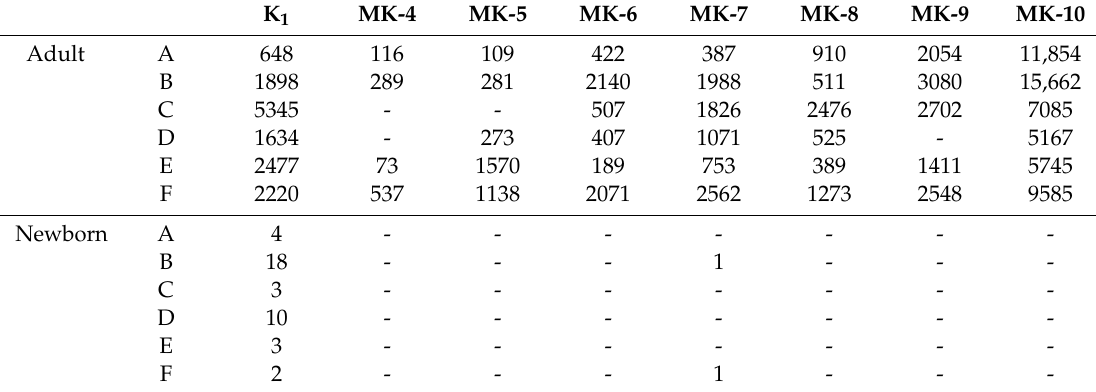
Table 2. Physiological fecal levels of vitamin K (phylloquinone (K1) and menaquinones (MK-4–10)) in normal adults and neonates (ng / g dry weight).